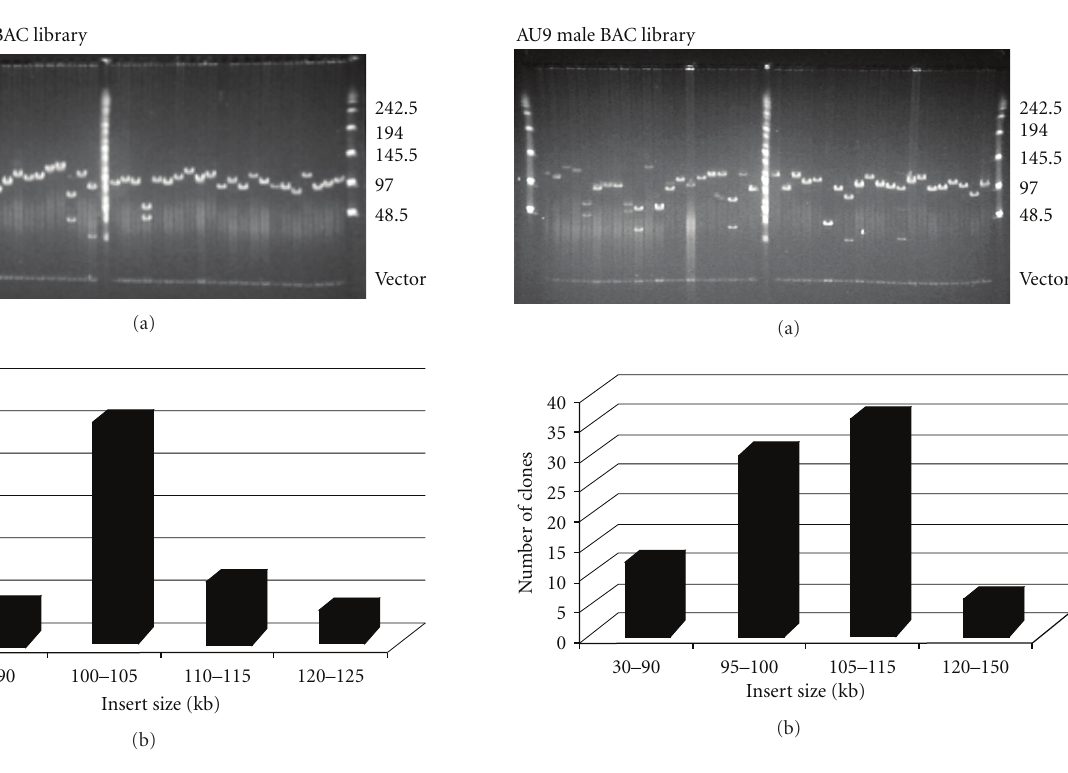
Figure 1: SunUp female BAC library and characterization. (a) Not I digests of BAC DNA isolated from 42 random BAC clones from the SunUp BAC library. The vector contains two Not I sites that flank the Eco RI cloning sites. The first and last lanes contain the DNA marker Lambda Ladder PFG marker (New England Biolabs, Beverly, MA, USA) and the middle lane contains the DNA marker PFG midrange I (New England Biolabs, Beverly, MA, USA). (b) Insert size distribution for Sunup female ranged from 85–125 kb with an average insert size of 104 kb.